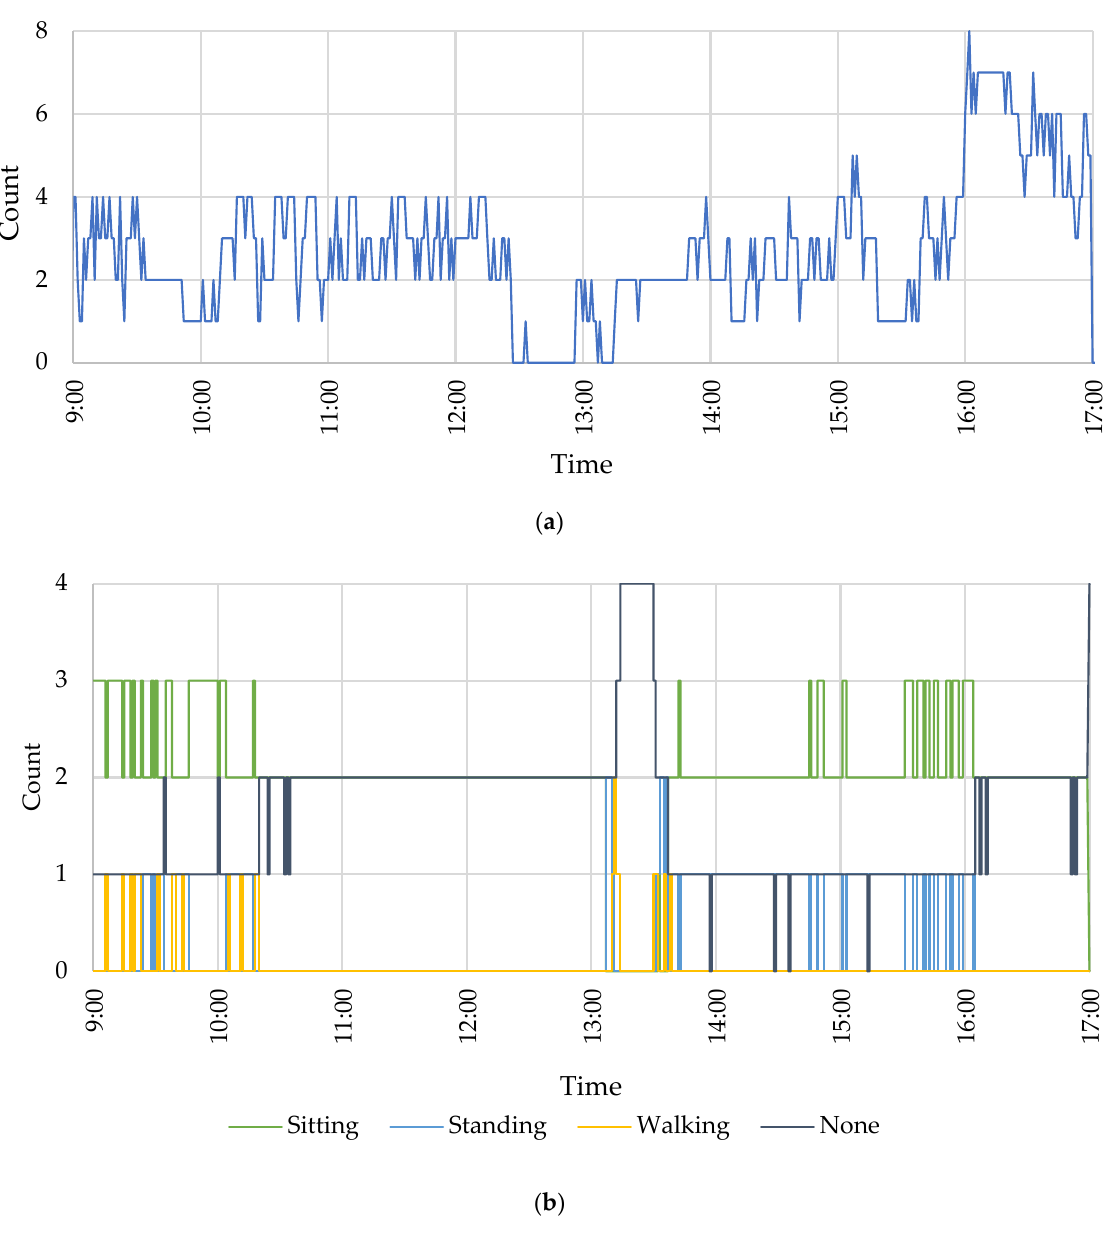
Figure 13. Detected ( a ) equipment, and ( b ) occupancy number profiles generated from the application of the deep learning method in the case study office.